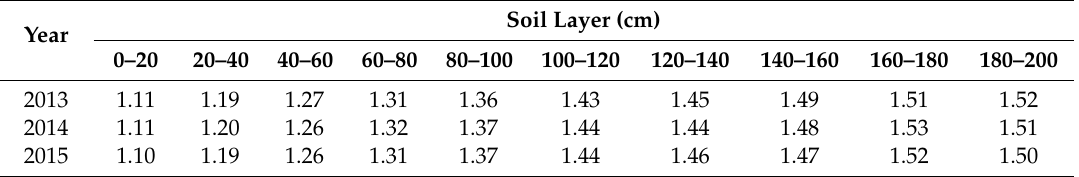
Table 2. Soil bulk densities from depths of 0–200 cm in 2013–2015 (g cm − 3